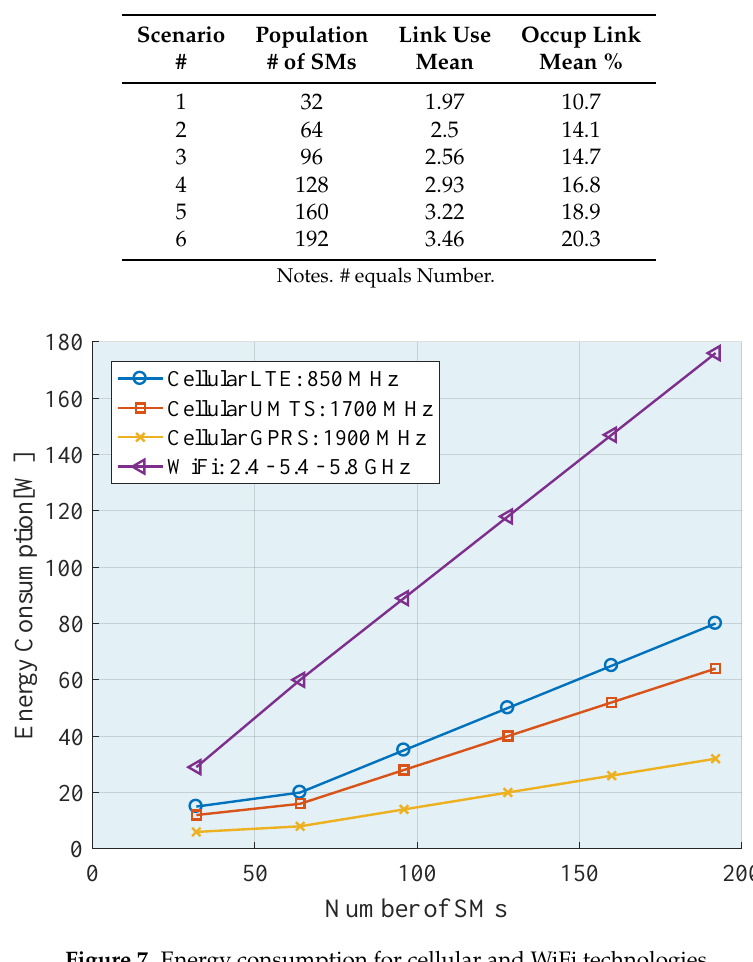
Figure 7. Energy consumption for cellular and WiFi